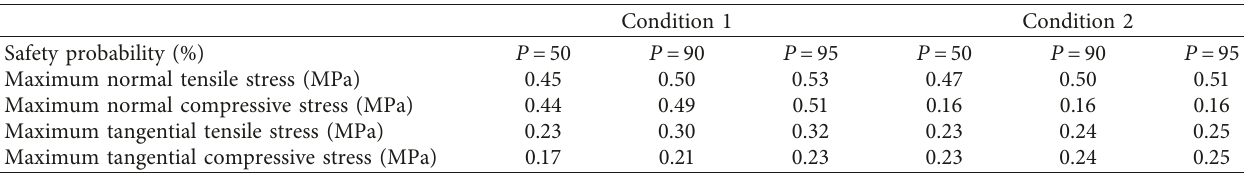
Table 9: Maximum stress of the interface.